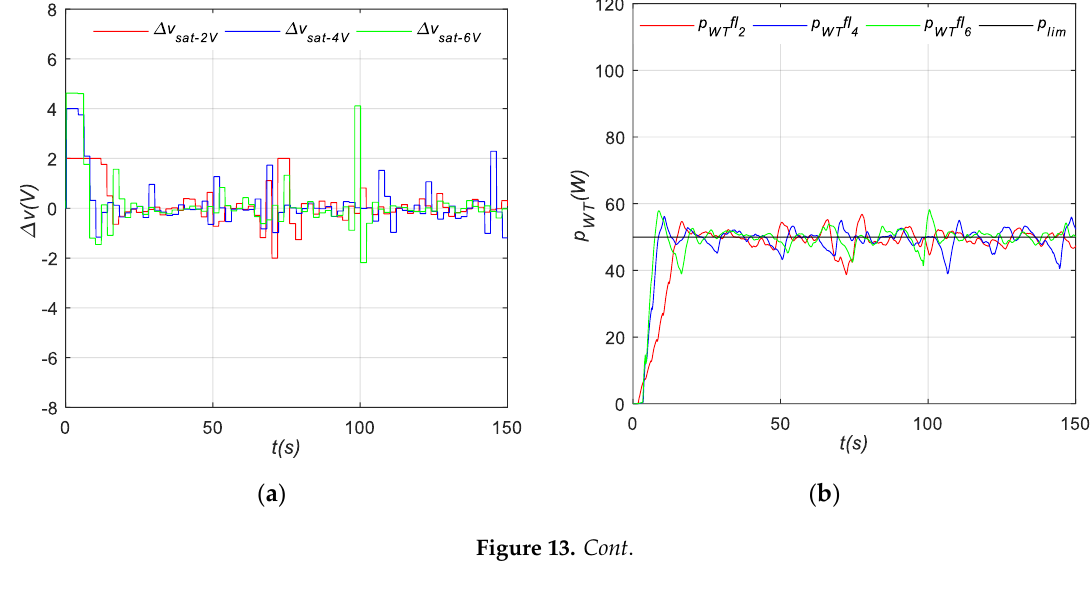
Figure 12. Newton’s variable step-size P&O for LPP2: ( a ) evolution of ∆ v ; ( b ) evolution of p WT ; ( c ) evolution of v WT ; ( d ) evolution of i WT .